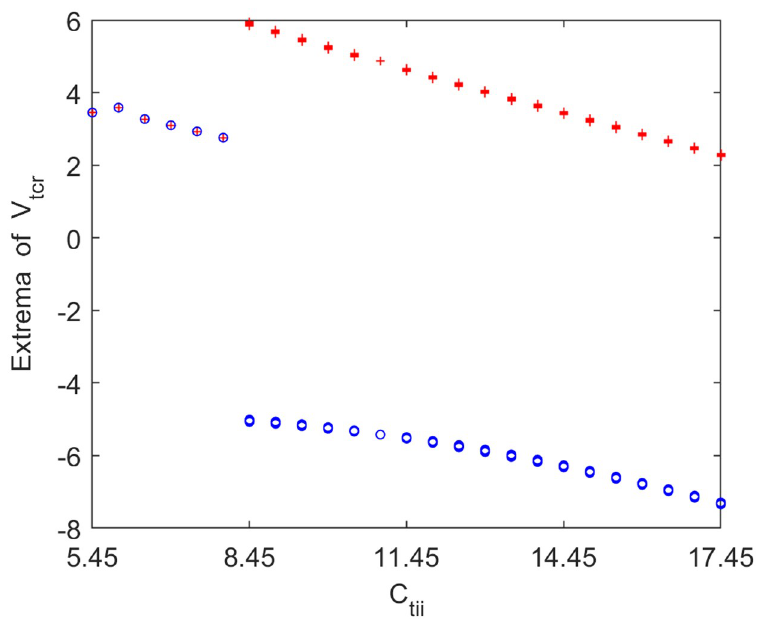
Fig 13. Bifurcation analysis of the thalamic module’s extrema for varying synaptic connection C points indicate the local maximum and minimum of the thalamic output, respectively.